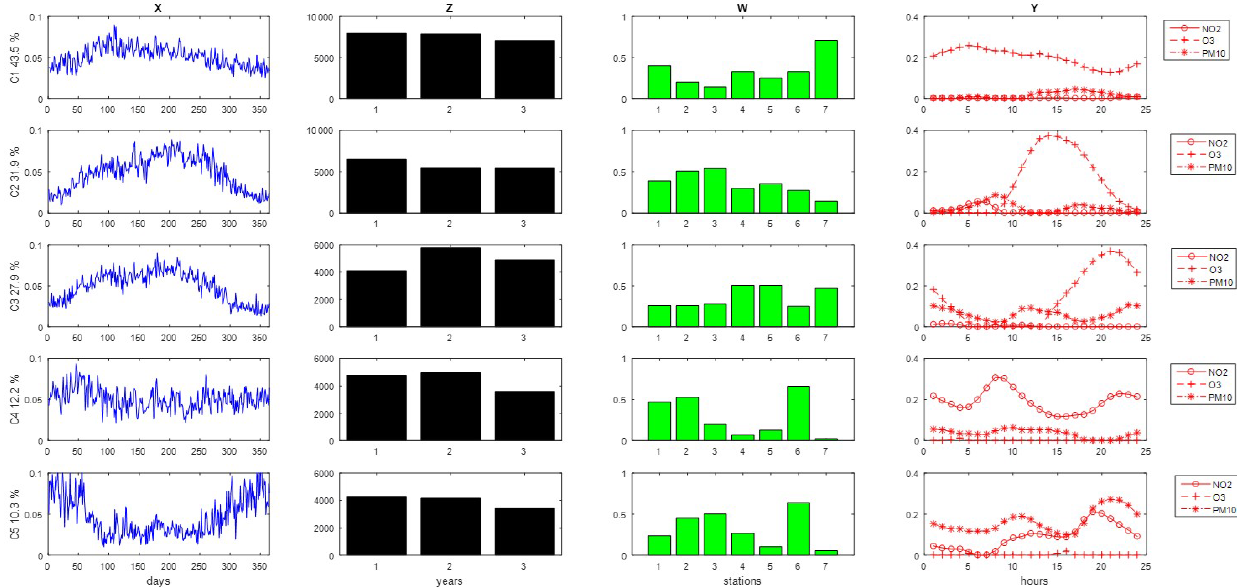
Figure 8. MCR-ALS results of the simultaneous analysis of NO 2 , O 3 and PM 10 for the entire years (incomplete super-augmented data matrix D Y12craug ) using non-negativity and quadrilinearity constraints. Profiles of the four different data modes are given in different colors: (X) in blue – days of the month April; (Z) in black – year; (W) in green – stations; and (Y) in red – hours. In the Y-mode, the hour profiles of the three contaminants are overlapped. The different stations are indicated as 1: Vall d’Hebron, 2: Granollers, 3: Manlleu, 4: Juneda, 5: Bellver, 6: Gràcia, 7: